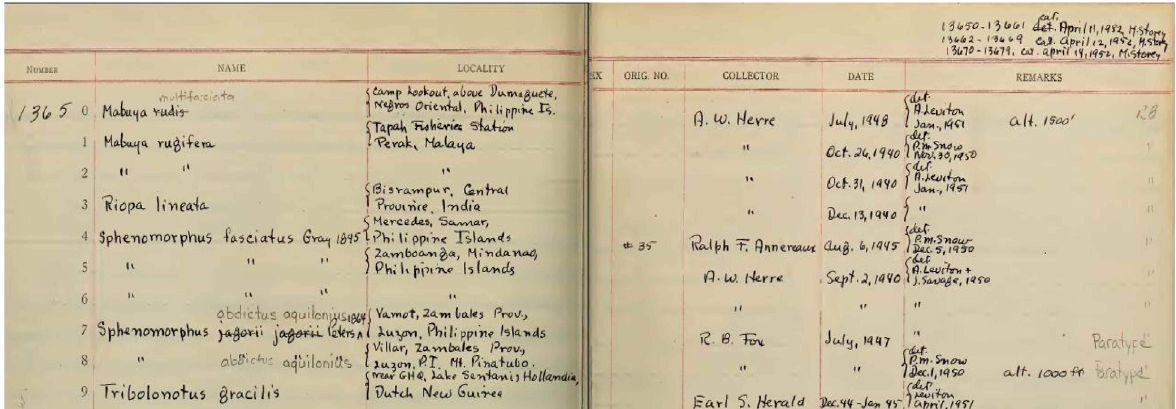
Figure 2. The evidence page from the catalogue shows note on collection of a specimen of Lygosoma lineate in the Natural History Museum of Stanford University’ (CAS, Herpetology Collections,